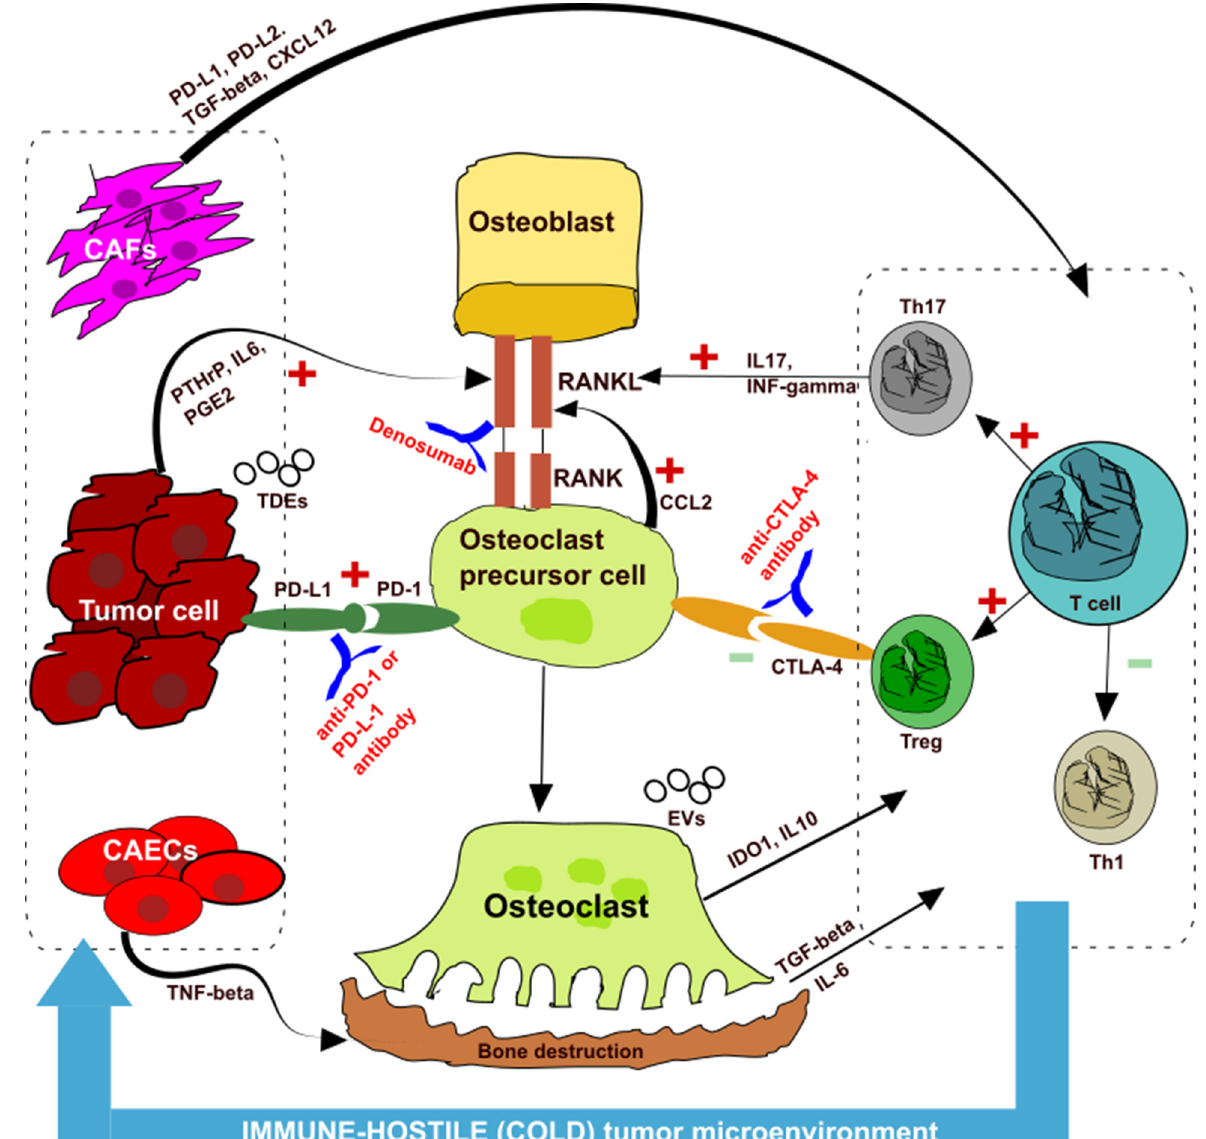
Figure 1. Interaction among the bone, immune system, and cancer cells. CAF: cancer-associated fibroblasts; CAECs: cancer associated endothelial cells; Th: T helper; Treg: regulatory T cells; PD-1: programmed-death 1; PD-L1: PD-ligand (PD-L1); CTLA4: cytotoxic T lymphocyte-associated protein 4; RANK: receptor-activator of nuclear kappaB; RANKL: receptor-activator of nuclear kappaB ligand; PTHrP: parathyroid hormone-related peptide; PGE2: prostaglandin E2; CCL2: chemokine (C-C motif) ligand 2; IDO–1: indoleamine 2,3-dioxygenase-1; IL: interleukin; TGF-beta: transforming growth factor-beta; IFN-gamma: interferon-gamma; TDE: tumor derived exosome; EVs: extracellular vesicles.